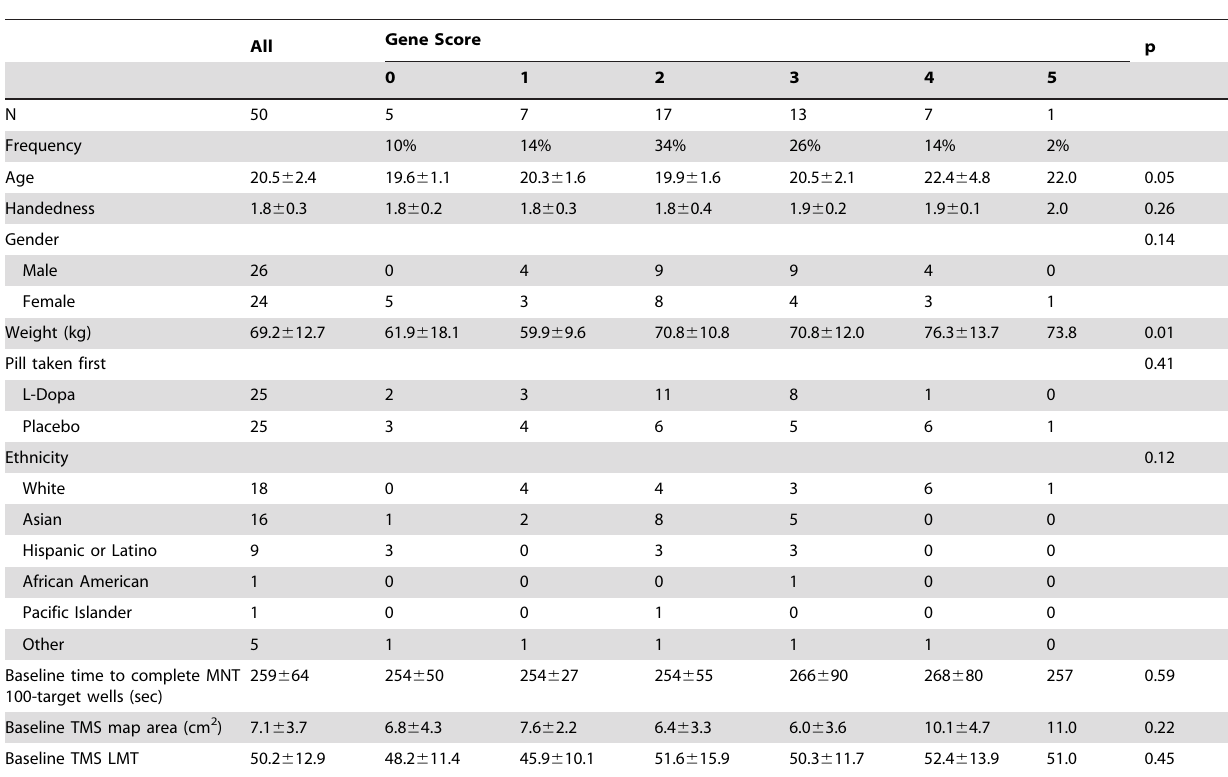
Table 2. Demographic and baseline data.